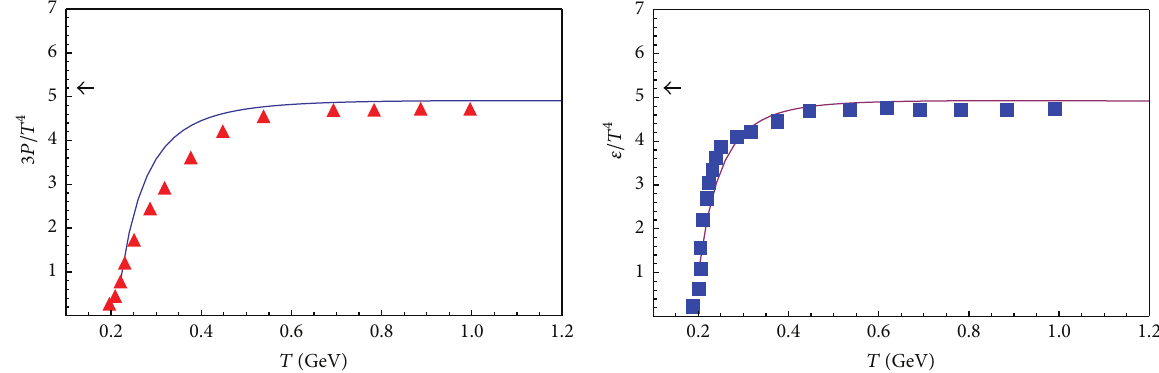
Figure 1: The symbols show the MC LR for the pressure and the energy density in the SU (3) gluodynamics [34, 35]; the line corresponds to the equation of state (35) for the pressure in the left panel and (36) for the energy density in the right panel with 𝜎 = 4.20719 , 𝐴 = −2.0019𝑇 3 𝑐 , and 𝐵 = −1.465358𝑇 4 𝑐 . The arrows in the above figures correspond to 𝑃/𝜀 = 1/3 (i.e., the SB limit).